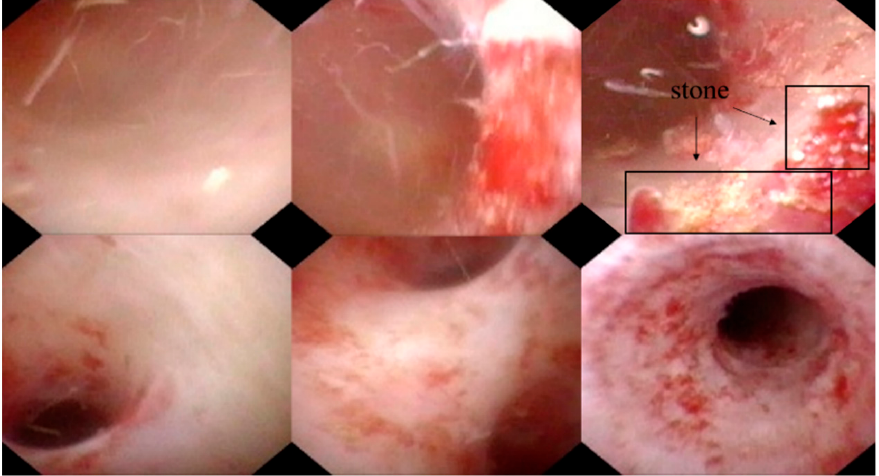
Figure 4. Examples of typical ureteroscope video images. The first row shows problematic or uninformative frames due to being blurry, kidney stones, or flocculent, and the second row displays informative images without any impurity. Table 2. Dataset composition of style transfer model.